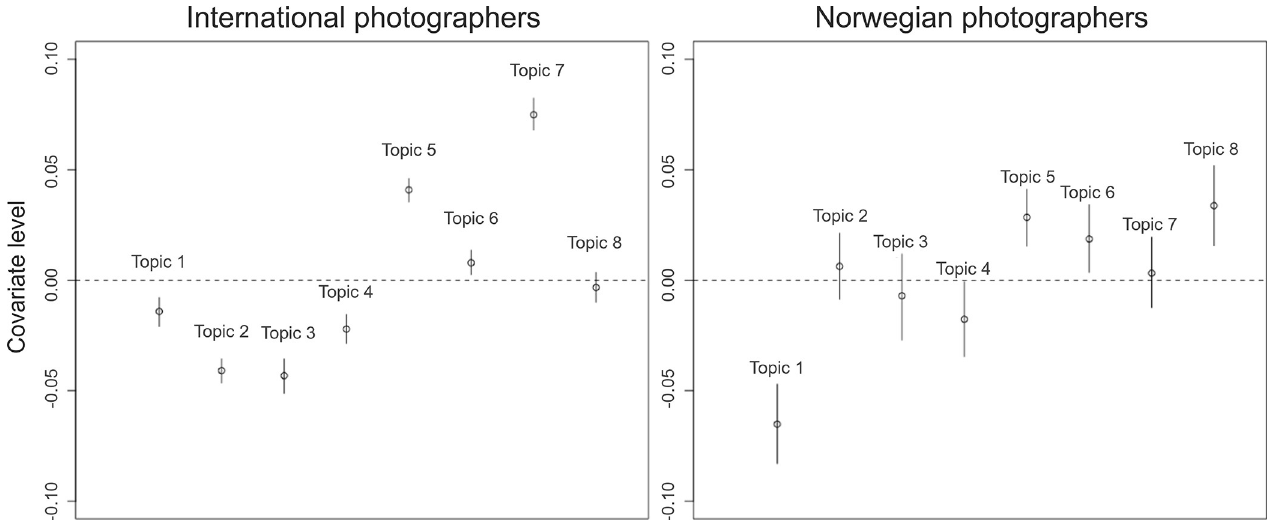
Fig 3. Topic covariate levels (in proportions) after COVID-19 measures, compared to before COVID-19 measures. Covariate levels > 0 indicate the topic was more prevalent after COVID-19 measures, compared to before the COVID-19 measures. The graph on the left illustrates changes in covariate levels after COVID-19 measures for international photographers, while the right graph illustrates changes in covariate levels for Norwegian photographers.